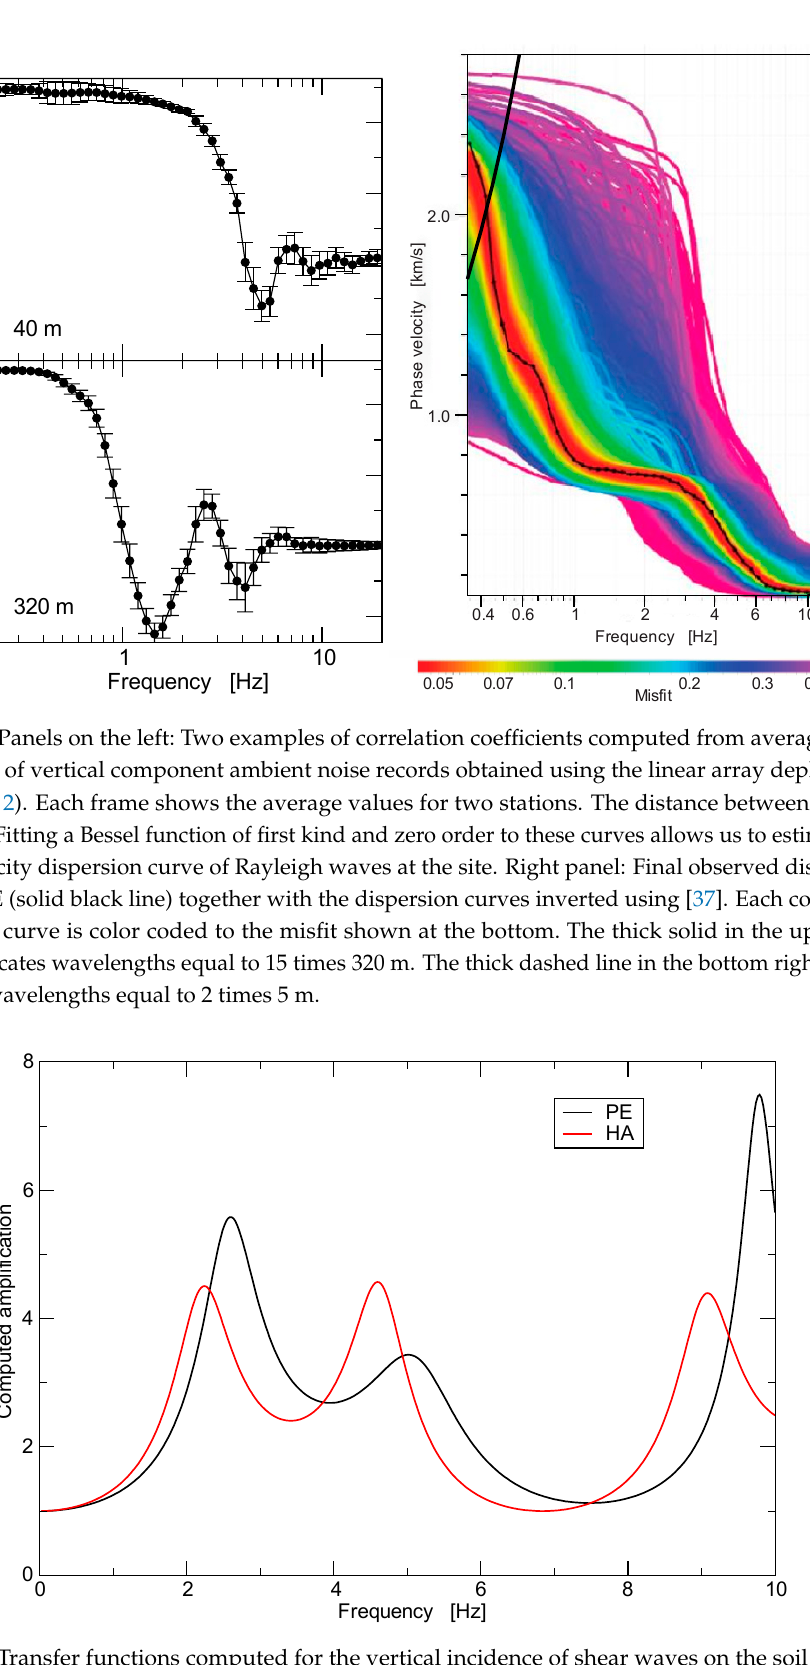
Figure 16. Transfer functions computed for the vertical incidence of shear waves on the soil profiles derived from the SPAC method at the sites, PE and HA, shown in Table 2. Lacking data, anelastic attenuation was neglected in this simulation.